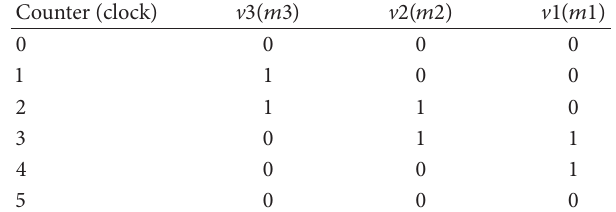
Table 3: Table of Johnson counter